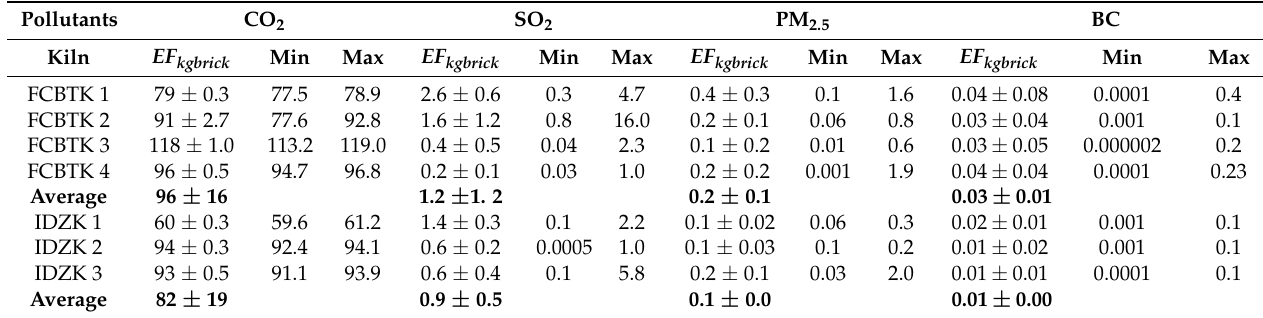
Table 6. Average EF kgbrick (g/kg brick) with standard deviations along with its minimum and maximum value for different pollutants in all the measured kilns. CO 2 values have been rounded off to the nearest whole number.